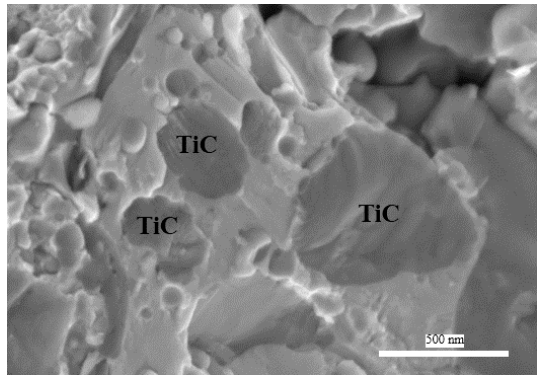
Figure 9. Fracture surface SEM image of a Fe 3 Al–TiC coating showing TiC particles embedded in the matrix.